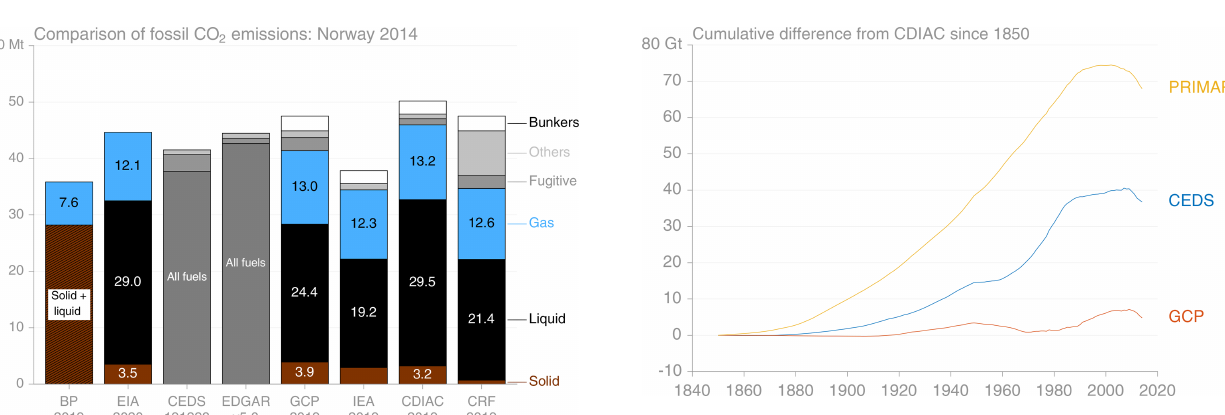
Figure 18. Difference of cumulative global CO 2 emissions from various datasets from those of CDIAC, starting in